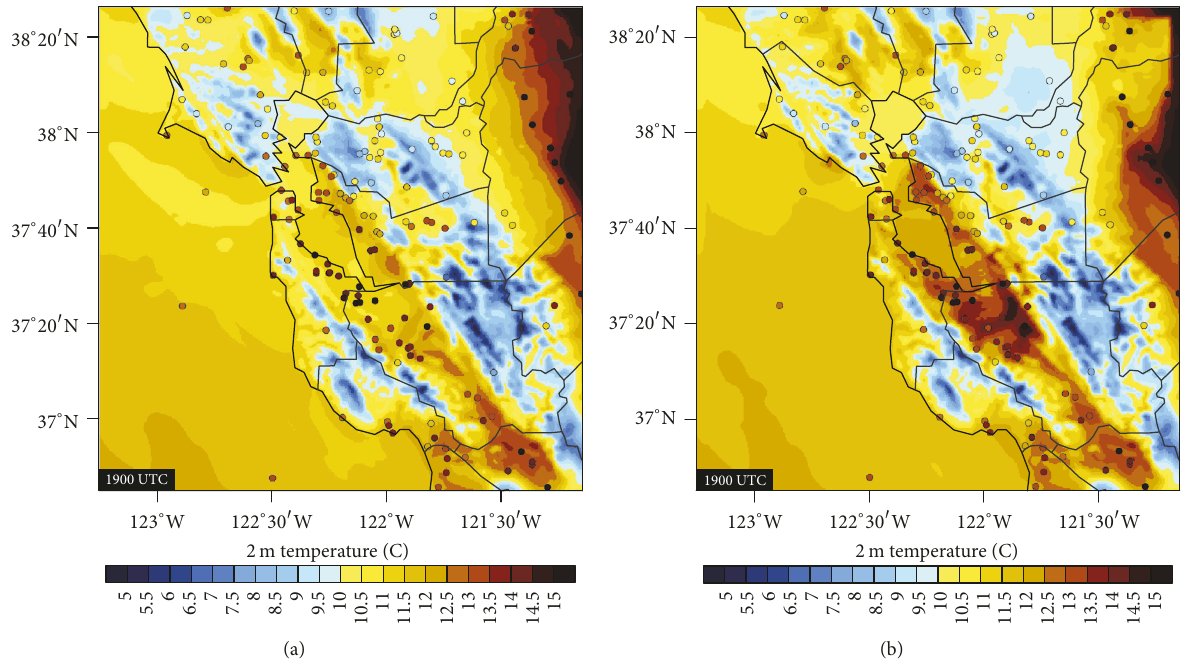
Figure 9: Model 1km horizontal grid spacing domain 1h forecast (19 UTC 7 February) 2 m temperature for (a) Exp. Control and (b) Exp. H45V75 with the observed 2 m temperature overlaid as colored circles centered over the observation locations.